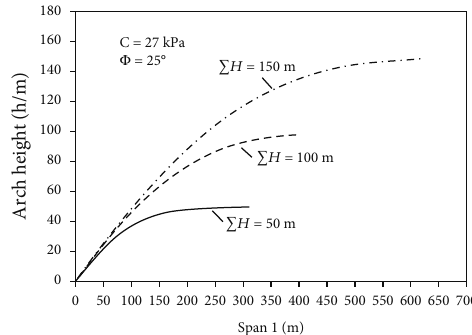
Figure 9: Variation of h with l under di ff erent loose layer thicknesses.